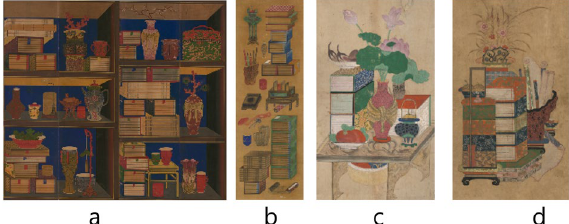
Fig. 2 Chaekgeori type. Note. a Bookshelf type, b Arragement type, c Table type, d Compact type [Source: National Museum of Korea collection (2021)] This figure (a, b, c, d) used ’Chaekgeori’, which was written by the "National museum of Korea" and opened as the first tupe of KOGL, and the figure can be downloaded for free from the ’National museum of Korea, https:// www. museum. go.